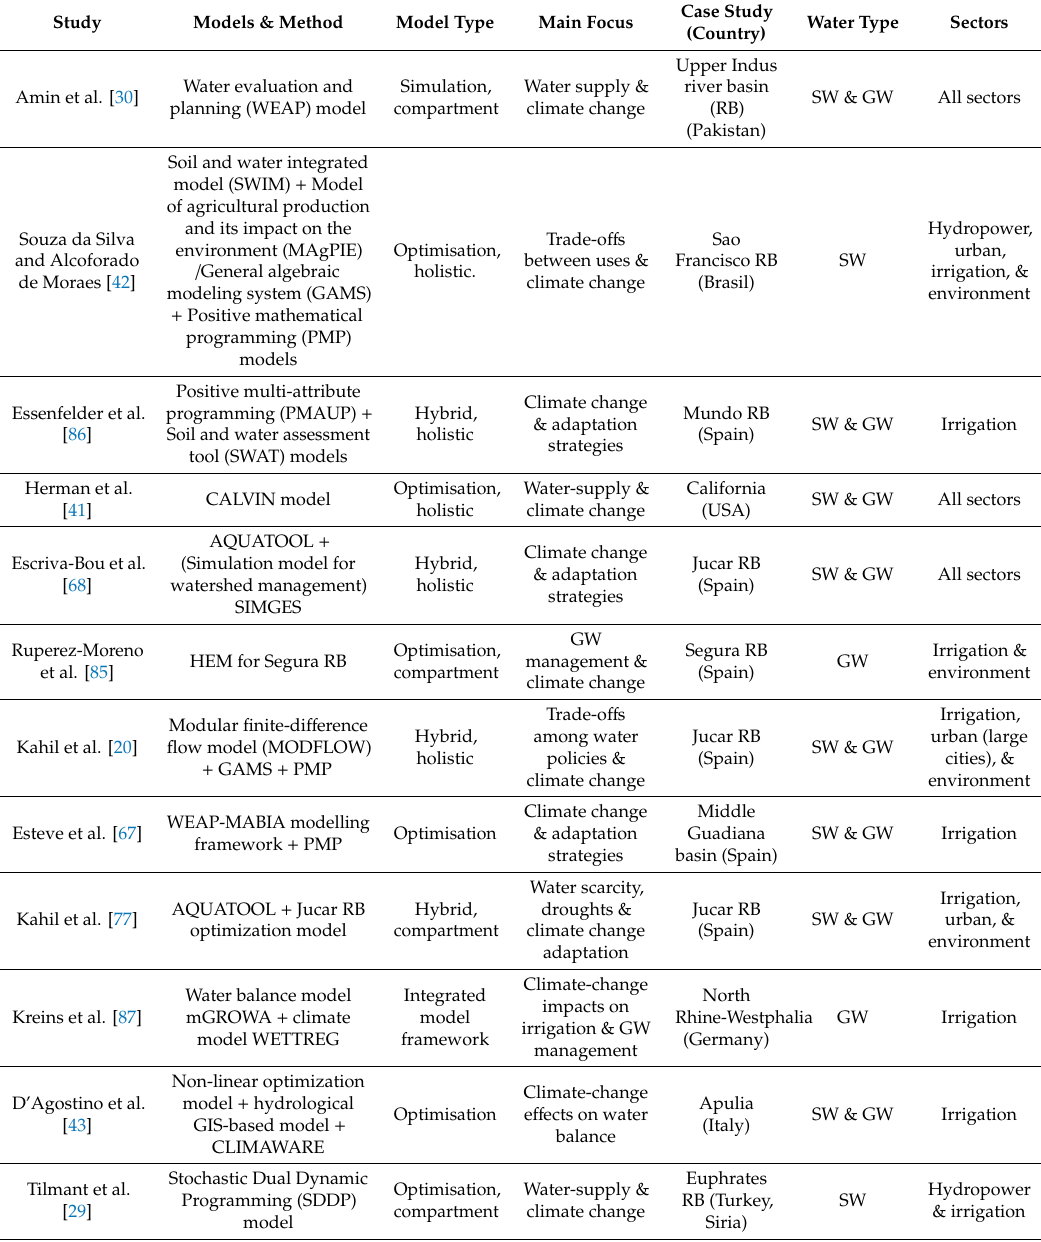
Table 1. Review of recent applications of HEMs that incorporate potential CC e ff